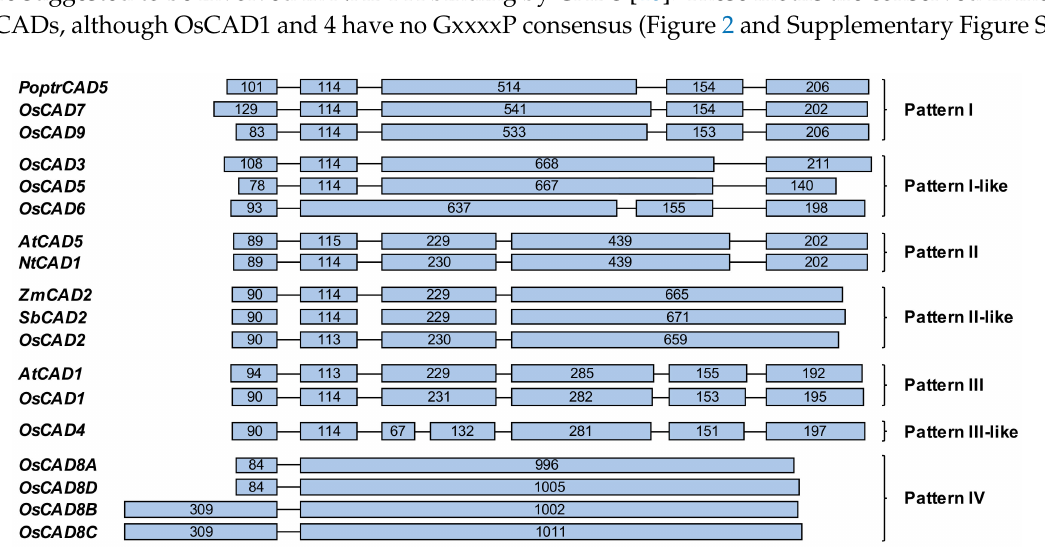
Figure 1. The exon-intron structures of the OsCADs and other plant CAD genes. Exons and introns are indicated by boxes and lines, respectively. The numbers in the boxes indicate the exon sizes, and the intron sizes are not to scale. The exon-intron patterns of the plant CADs are indicated on the right side. A. thaliana CAD ( AtCAD ), Z. mays CAD ( ZmCAD ), P. trichocarpa CAD ( PoptrCAD ), S. bicolor CAD ( SbCAD ) and N. tabacum CAD ( NtCAD